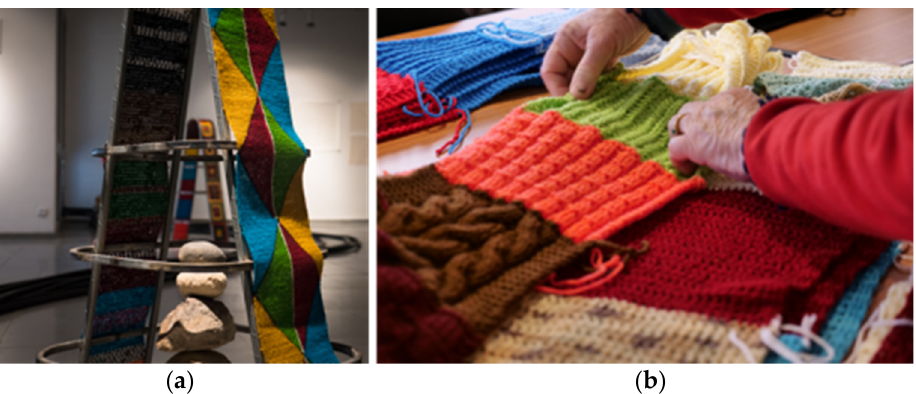
Figure 12. The preparation process of the Rujum sculpture, 2020. ( a ) The Rujum sculptures presented at the “ Common Views: Sourcing Water ” Exhibition, ACAC, Arad, 2020, curated by: Irit Carmon Popper. ( b ) Women Knitting group from Arad Community Center, 2020. Photographed by Dan Farberoff. Images courtesy of the artist.